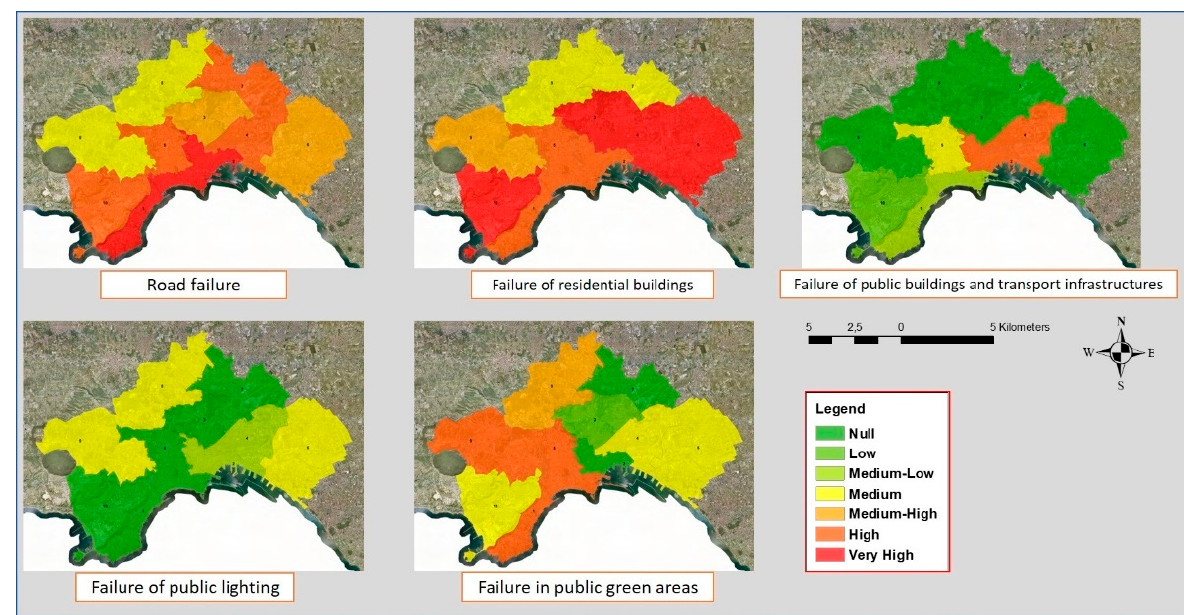
Figure 7. Category thematic maps obtained in the year 2021.